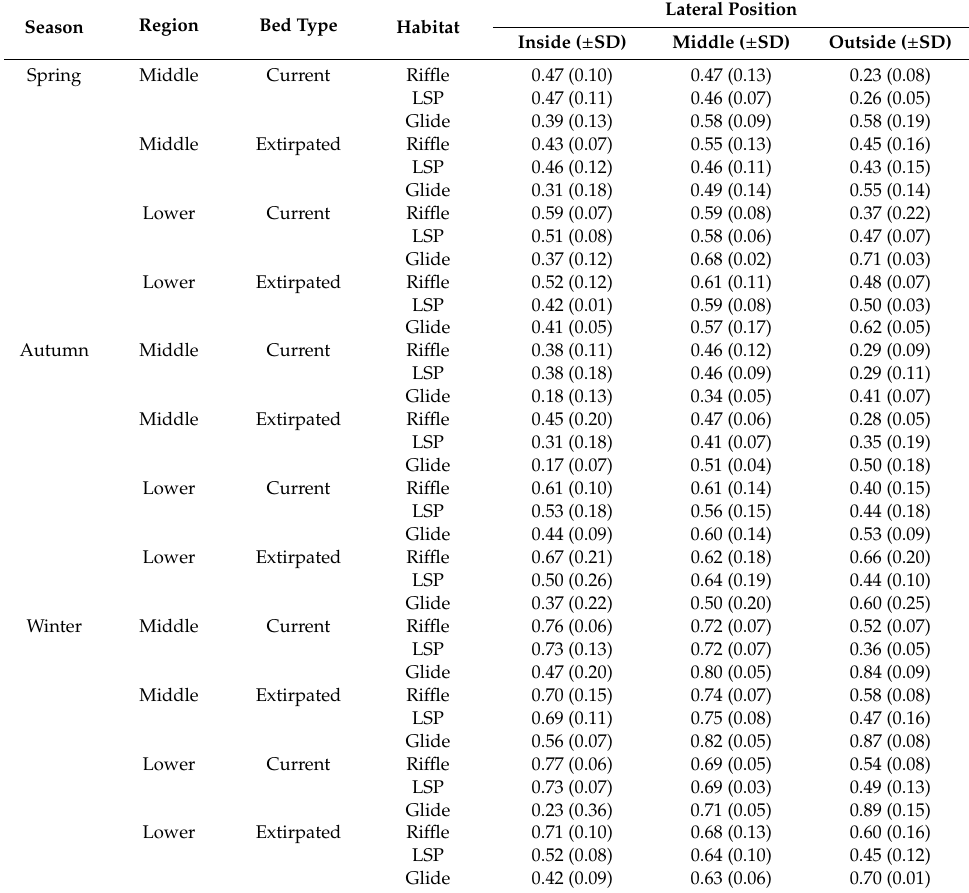
Table A2. Pooled cell mean estimated bed velocity (m · s − 1 ; ± SD) by lateral position (Inside, Middle, Outside) across seasons (Spring, Autumn, Winter), regions (Middle, Lower), bed type (Current, Extirpated), and habitat (Ri ffl e, LSP, Glide).